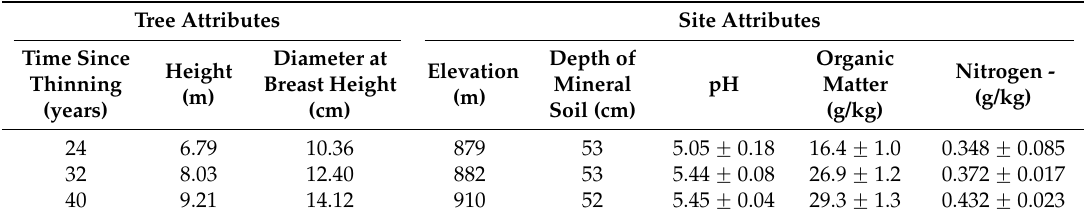
Table 1. Tree and site attributes since